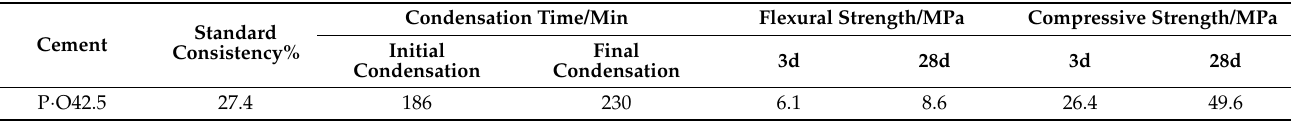
Table 2. Physical and mechanical properties of